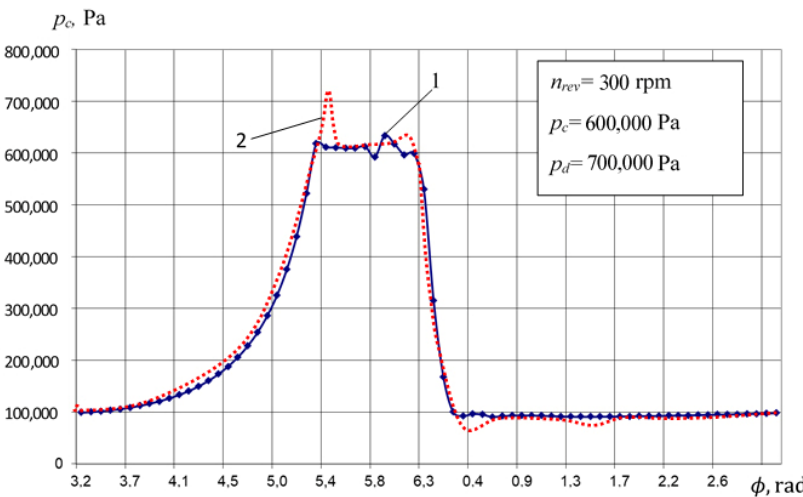
Figure 10. Dependence of the instantaneous pressure in the compressor section in the crosshead-free PHPM determined experimentally and by calculation (1—Calculation; 2—Experiment).